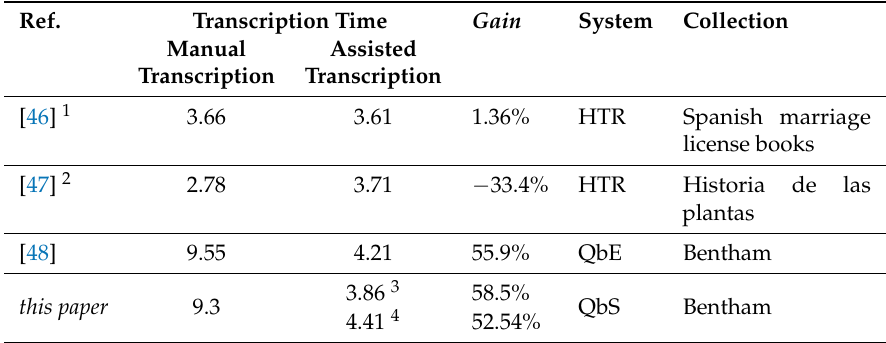
Table 6. Comparison of systems for the assisted transcription of historical documents. Transcription time is measured in seconds per word. Values reported in this table are computed starting from the data reported in each paper as described in the